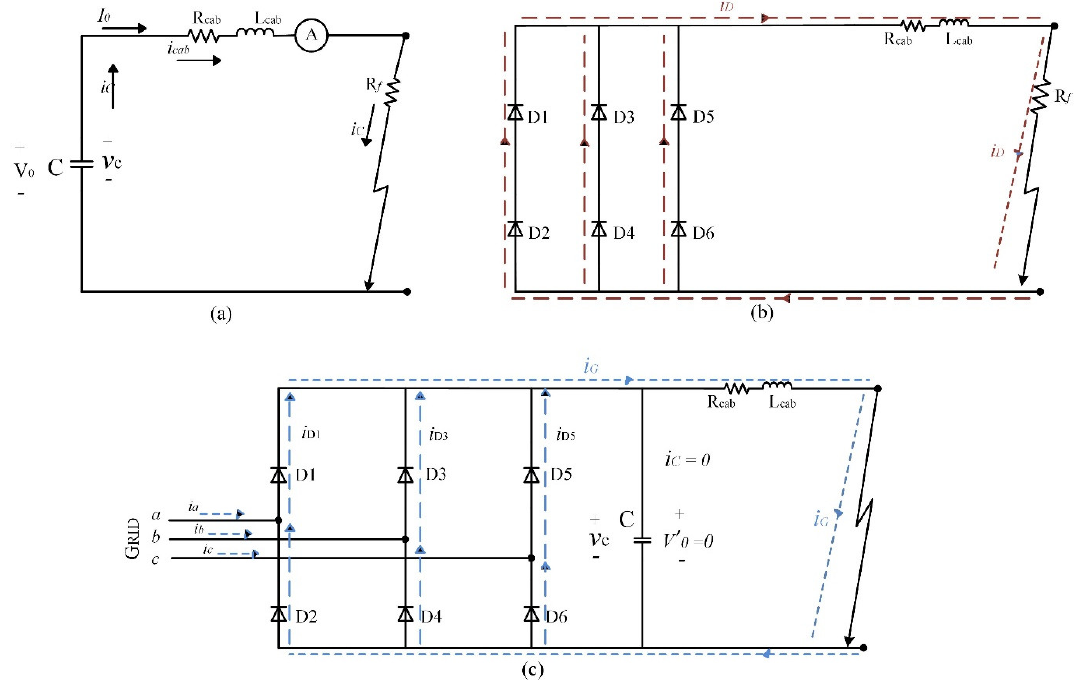
Figure 6. Three stages of fault current for pole-pole short-circuit fault. ( a ) Capacitor discharging stage. ( b ) Free-wheeling stage. ( c ) AC-side current feeding stage.